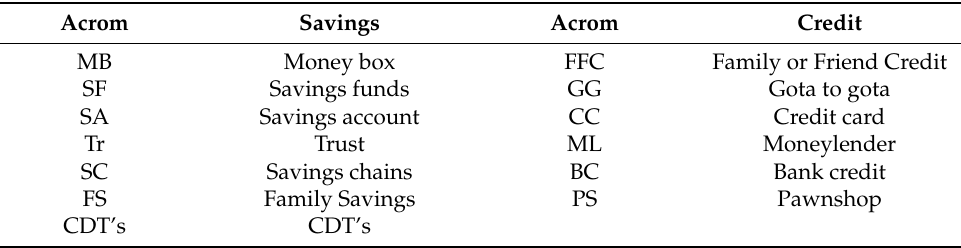
Table 2. Savings and credit